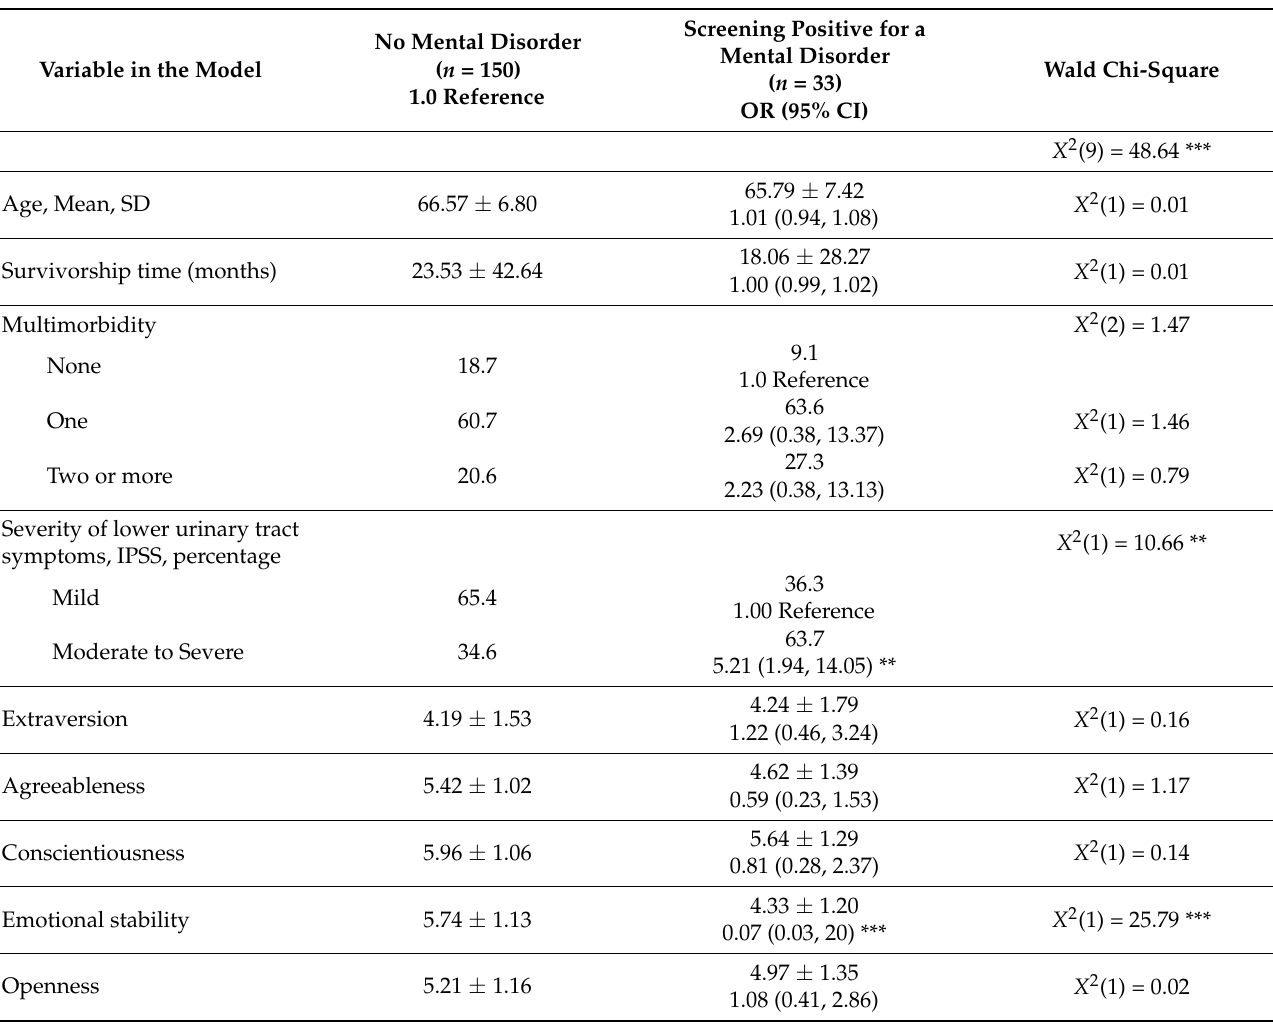
Table 3. Multivariate Logistic Regression analysis predicting mental health screening results by personality types, urinary symptoms severity while controlling for age, survivorship time, multimorbidity, among adult men residing in Nova Scotia, aged 50 to 83 years old, between 2017 and 2019, n =